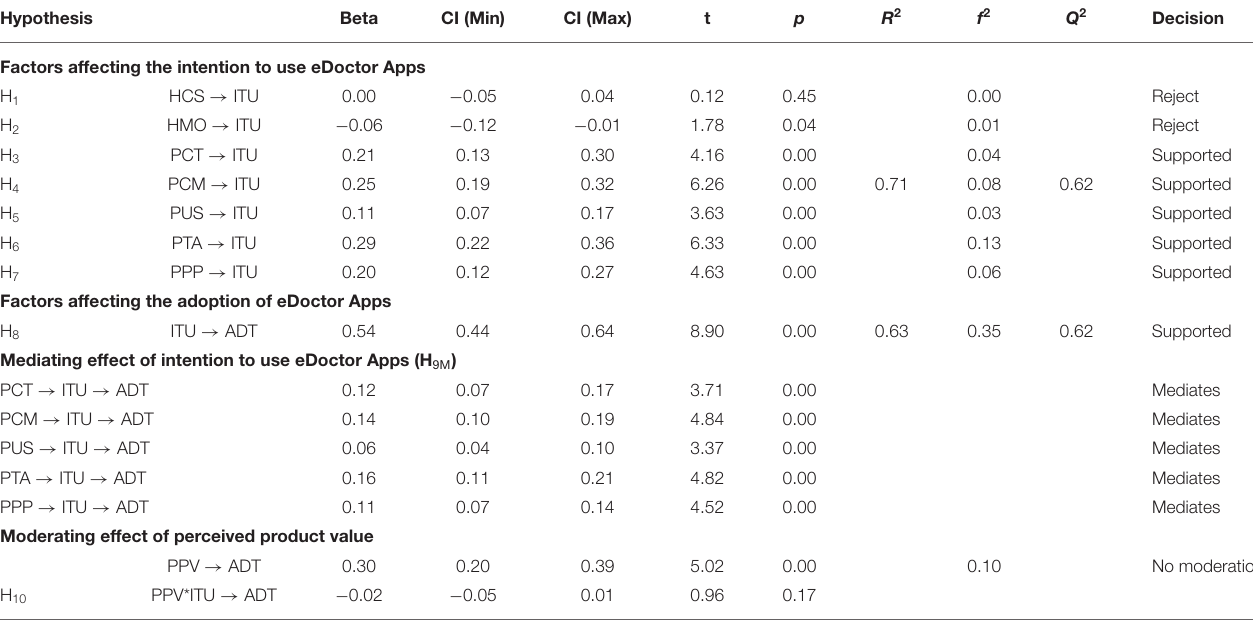
TABLE 5 | Hypothesis